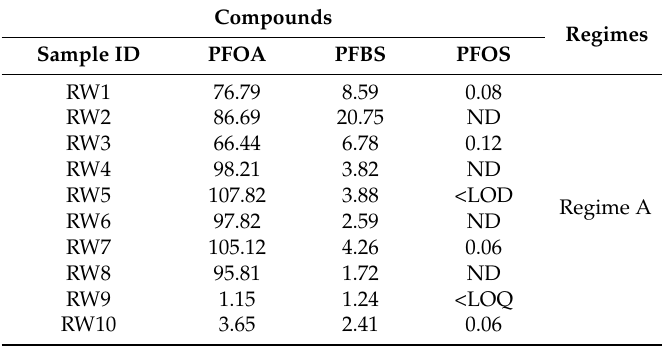
Table 2. Concentration of PFOA, PFOS and PFBS in river water